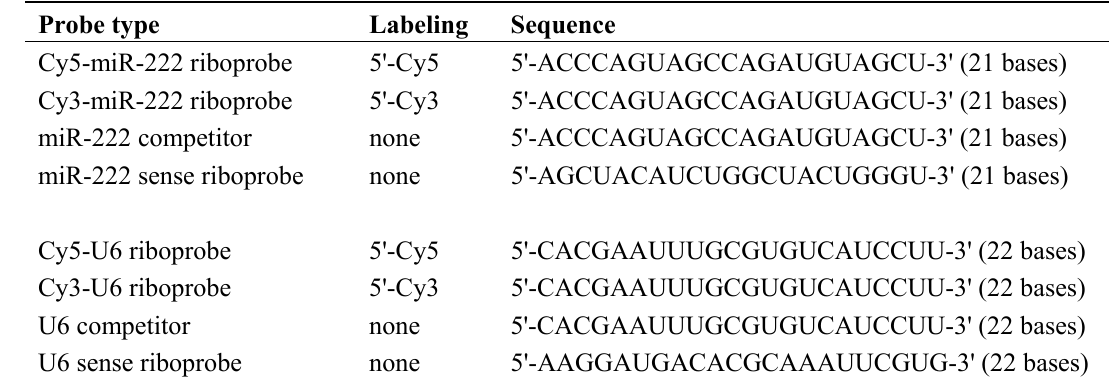
Table 1. Probe types for RNase protection